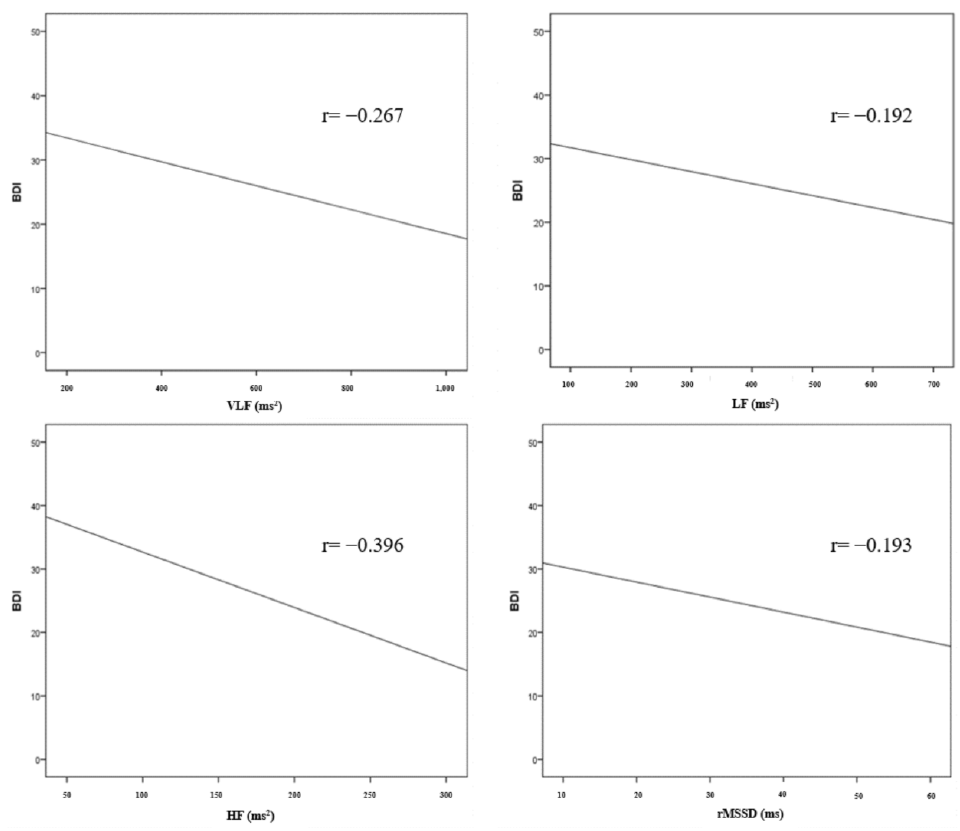
Figure 1. Correlation between HRV parameters and BDI.